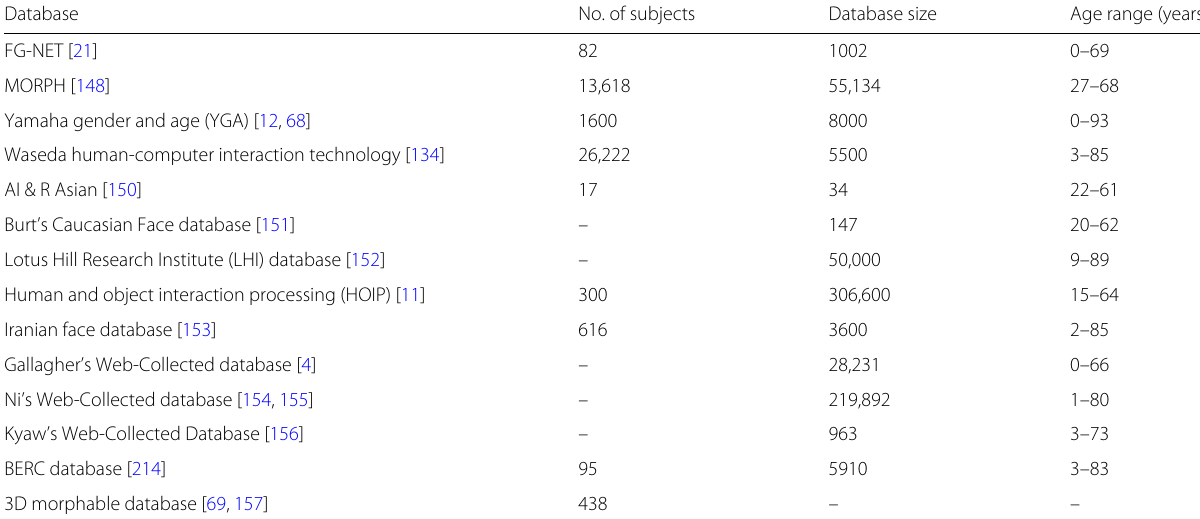
Table 2 Summary of facial aging databases